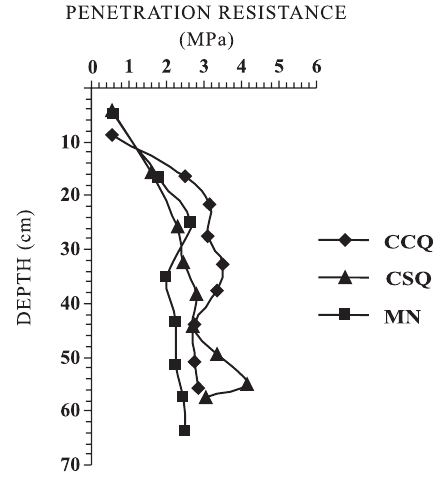
Figure 1. Resistance to vertical penetration in dystrophic Rhodic Haplustox to a depth of 0.70 m under burnt cane harvesting (BCH), mechanized cane harvesting (MCH), and native forest